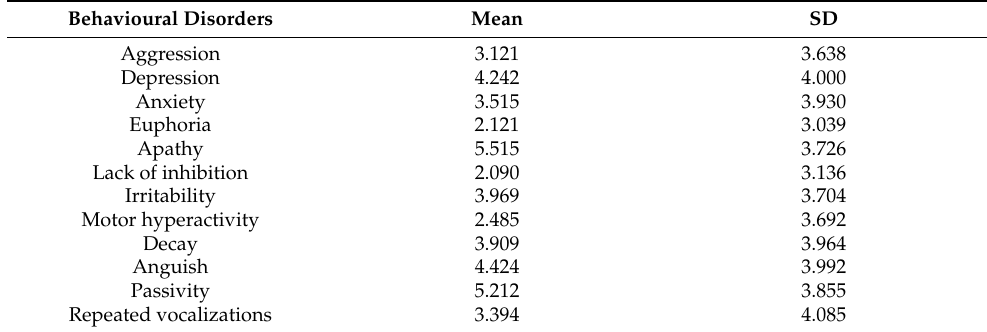
Table 5. Behavioural Disorders.